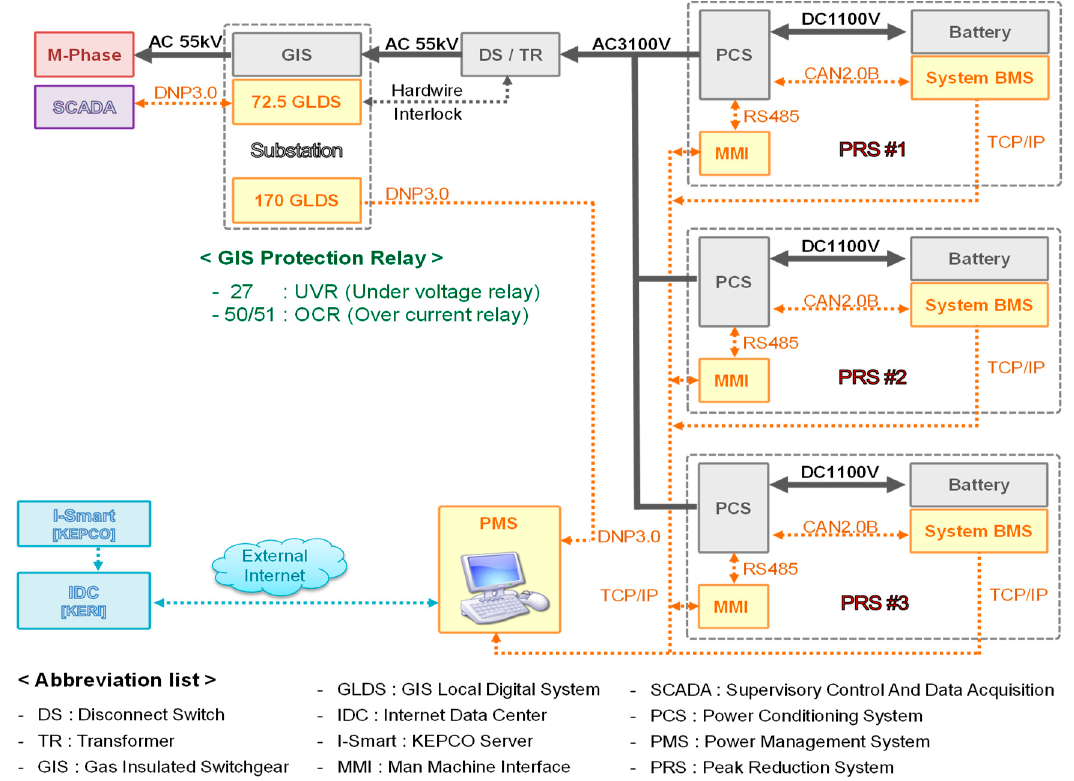
Figure 1. Configuration of peak power reduction system.